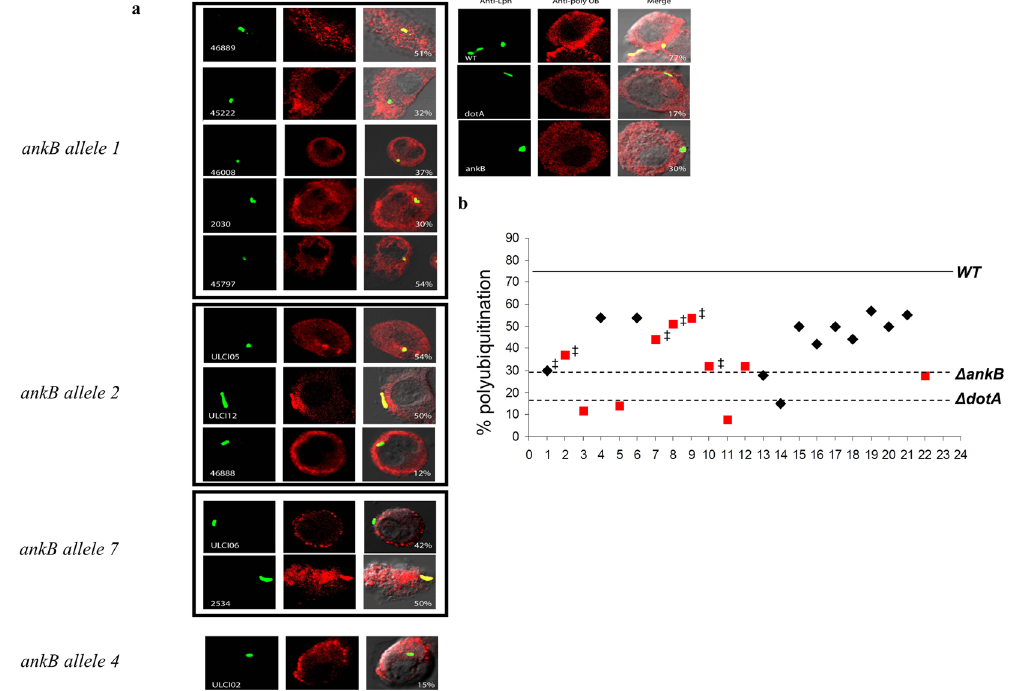
Figure 2. AnkB-genotype does not predict the ability to recruit polyubiquitinated proteins to the LCV. ( a ) Representative confocal microscopy images of polyubiquitinated protein recruitment to the LCV among 23 different isolates of L . pneumophila expressing various ankB alleles. Percentages indicate the number of LCVs positive for ubiquitin. Images in the right panel were taken using the AA100 strain. ( b ) Distribution of percent polyubiquitin recruitment among 23 different isolates of L . pneumophila . Environmental isolates are shown in red and clinical isolates are shown in black. ‡ , indicates strains carrying the ankB1